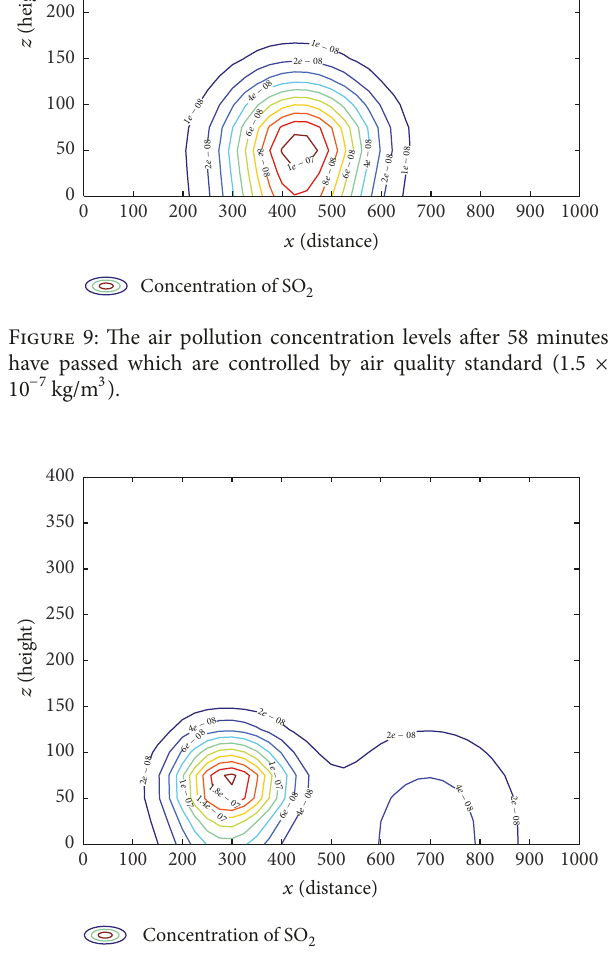
Figure 10: The air pollution concentration levels after 1 hour and 36 minutes have passed which are controlled by air quality standard ( 1.5 × 10 −7 kg/m 3 ).